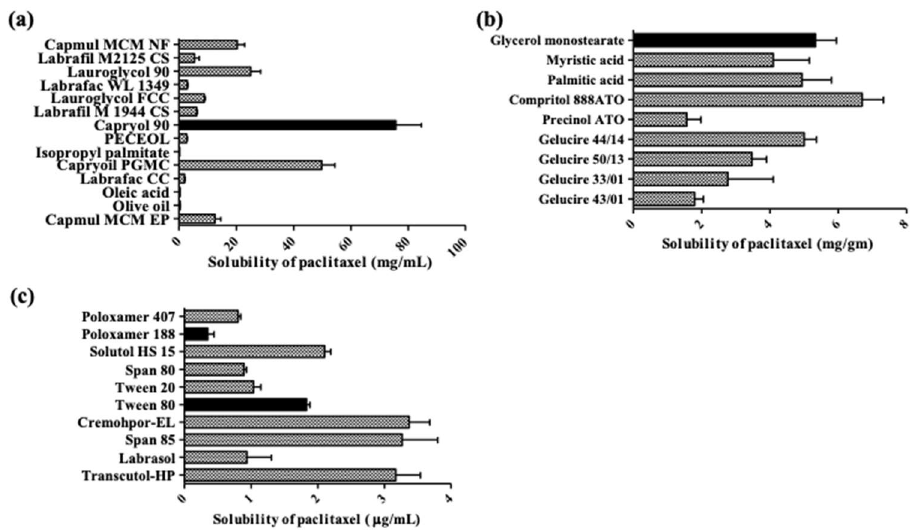
Figure 1. Solubility profiles of paclitaxel (PT) in lipids or surfactants. ( a ), liquid lipids; ( b ), solid lipids; ( c ), 1% surfactant solutions. Black bar represents the liquid, solid lipids and surfactants for PT-nanostructured lipid carrier (NLC).